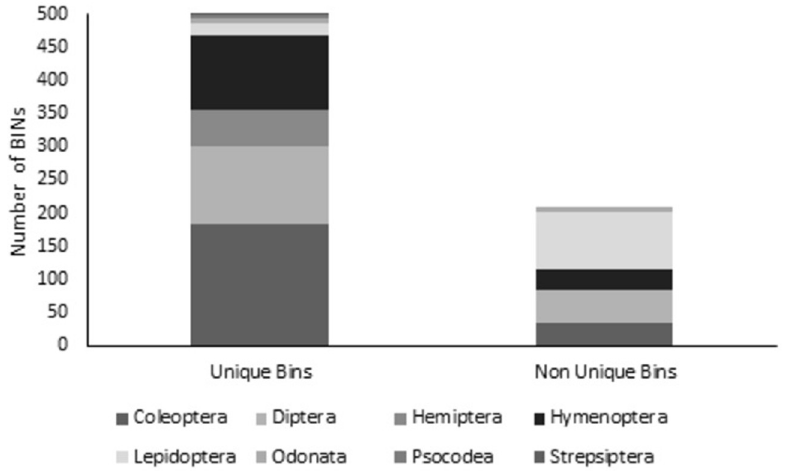
cies (x2 = 29.5, df = 1, P < 0.001), genera (x2 = 67.7, df = 1, P < 0.001), and families (x2 = 8.3, df = 1, P = 0.004). Comparisons of the performance of BOLD and BLAST by orders at the dif- ferent taxonomic levels revealed significantly more matches with BOLD (Fig 3), at the family level (Fig 3A) in Coleoptera (x2 = 7.7, df = 1, P = 0.006), at genus level (Fig 3B) in Coleoptera (x2 = 72.8, df = 1, P < 0.001) and Lepidoptera (x2 = 8.4, df = 1, P = 0.004) and at the species level (Fig 3C) in Coleoptera (x2 = 19.8, df = 1, P < 0.001) and Lepidoptera (x2 = 7.7, df = 1,